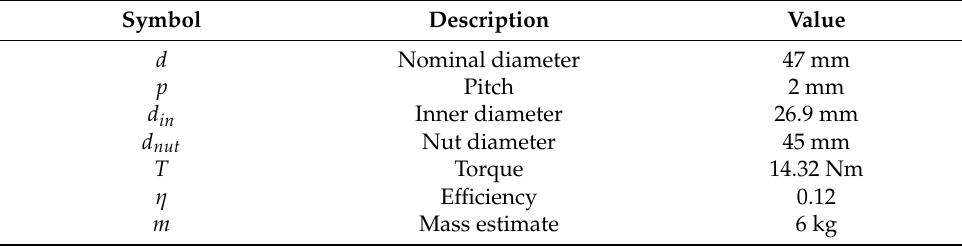
Table 3. Screw design